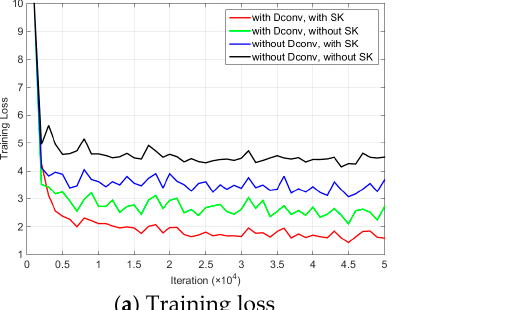
Table 7. Runtime comparisons for five despeckling methods with an image of size 256 × 256 (s). Method